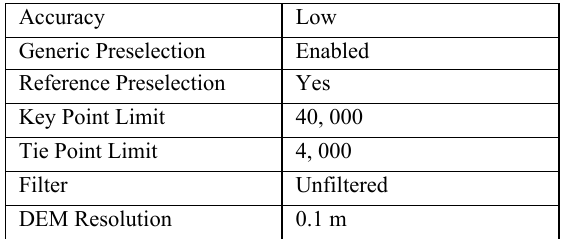
Table 1. SfM parameter settings in Agisoft Photoscan